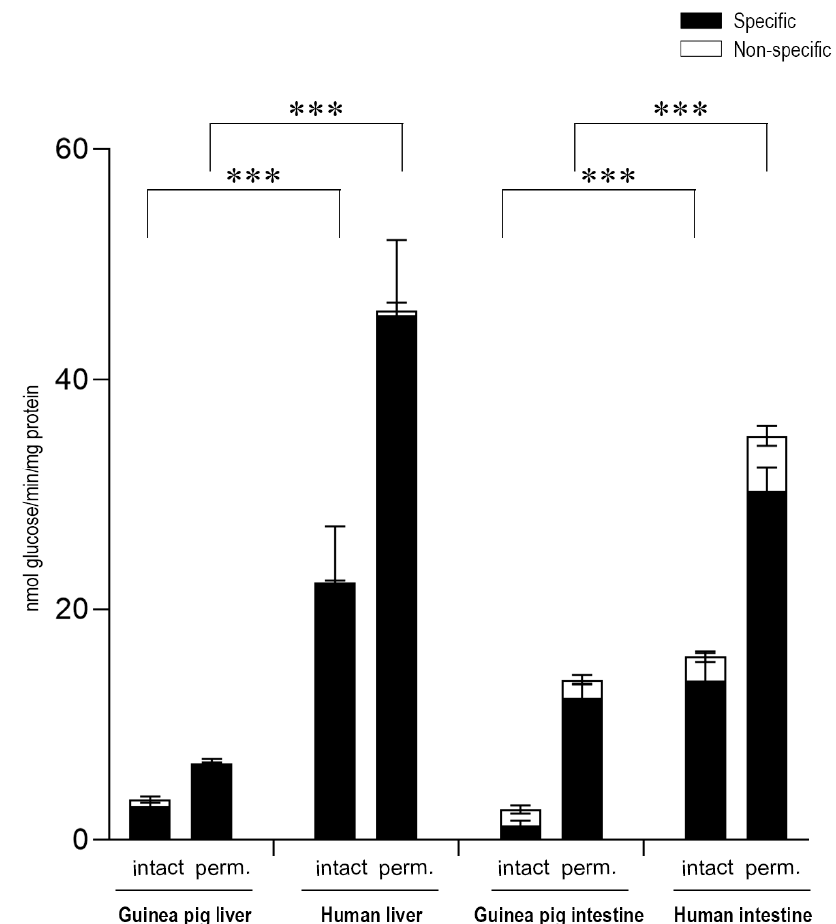
Figure 6. Fructose-6-phosphate-dependent glucose production in liver and intestinal microsomes. All samples were washed three times and incubated at 37 ◦ C in the presence of 10 mM of the fructose-6-phosphate substrate for 5 and 30 min. The figure shows the average activity measured in these time points. All experiments were performed in triplicate and repeated three times; n = 3 for all species. Bars display mean ± SEM, and statistical analysis was performed using a one-way ANOVA with a Tukey post hoc test, with p ≤ 0.001 ***. Perm. = Permeabilized microsomes treated with the pore-forming agent alamethicin in a 0.05 mg / mg microsomal protein concentration. Intact = Non-permeabilized microsomes containing intact microsomal membrane. F6P = Fructose-6-phosphate. Activity measurements were performed by the specific inactivation of G6Pase with a brief exposure of the samples to pH 5.0. Specific G6Pase activity was calculated as the di ff erence between untreated and pH 5.0 treated samples.